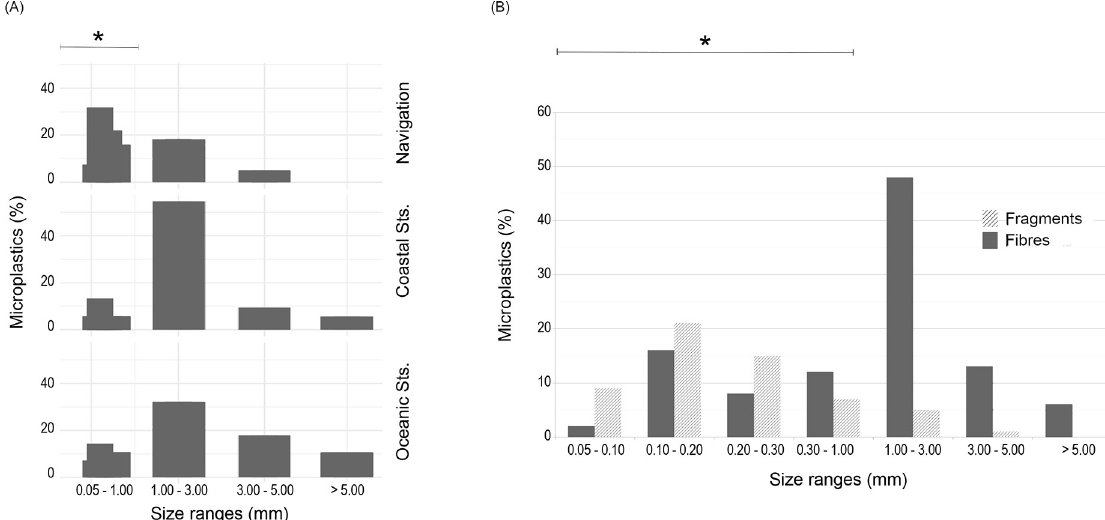
Fig 6. Size distribution for microplastic particles found. (A) Size distribution for microplastic particles found, separated by sample type; (B) Smallest size range separated into fractions from 0.05 to 0.10 mm; 0.10 to 0.20 mm; 0.20 to 0.30 mm and 0.30 to 1.00 mm, corresponding to the mesh sizes